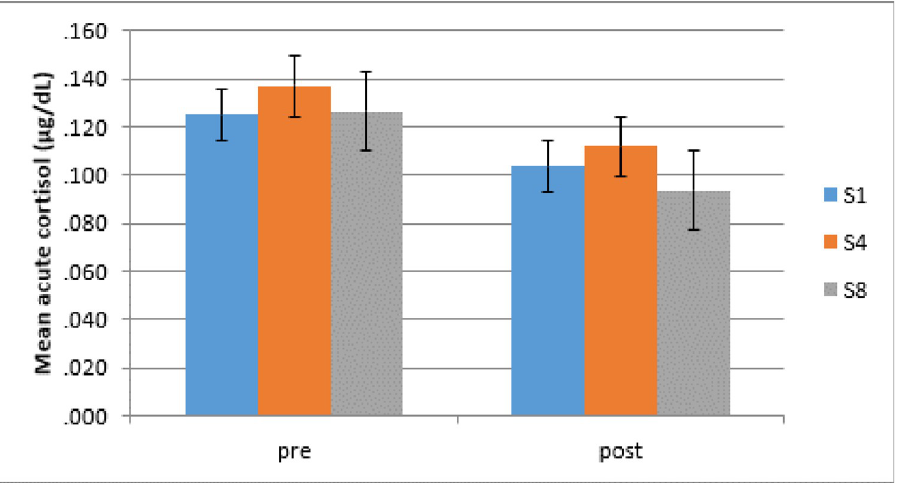
Fig 6. Mainstream schools: Mean acute cortisol before and after individual intervention sessions week 1, 4 and 8 (S1, S4, S8). Acute cortisol depicted before and after individual intervention sessions for week 1, 4 and 8 (S1, S4, S8). Error bars indicate standard error of